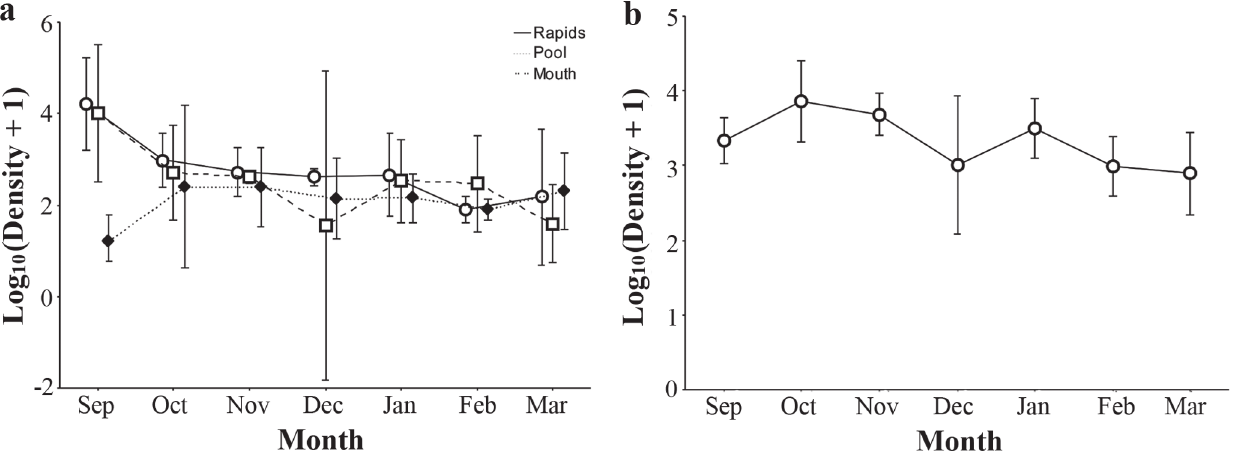
Fig. 3 . Average densities (± standard error) of the zooplanktonic organism spatial-temporal distribution ( a ) and the benthic organism temporal distribution ( b ) in the sampling sites of Ligeiro River during the months of September through